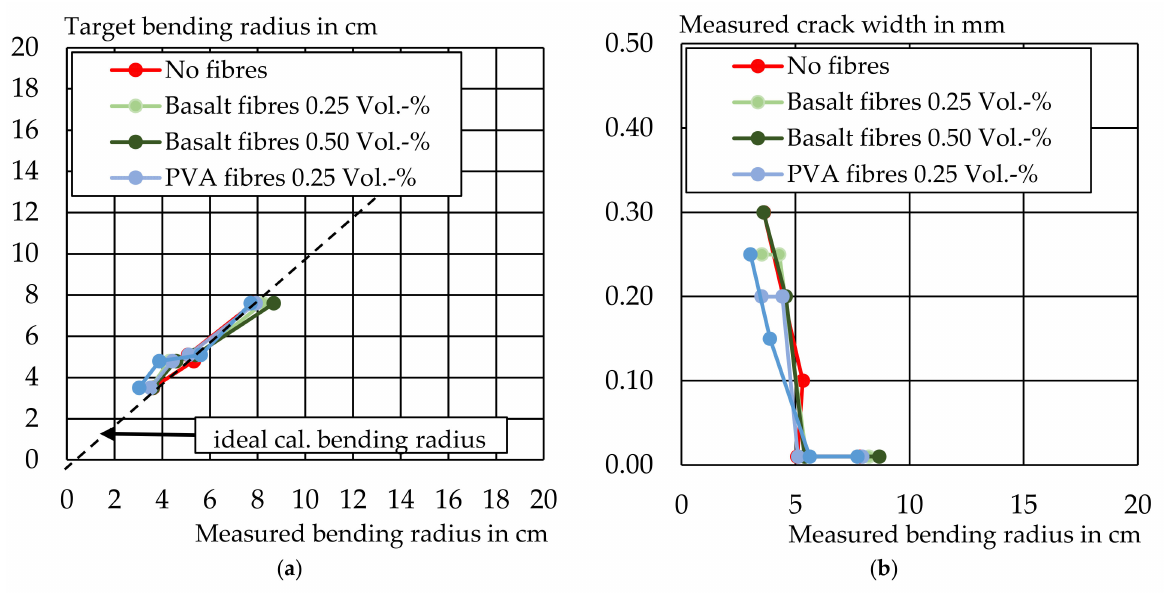
Figure 8. ( a ) Target and the measured bending radius for the transverse forming of the extruded mortar specimens; ( b ) crack width vs. measured bending radius for the transverse deformation of the extruded mortar specimens.